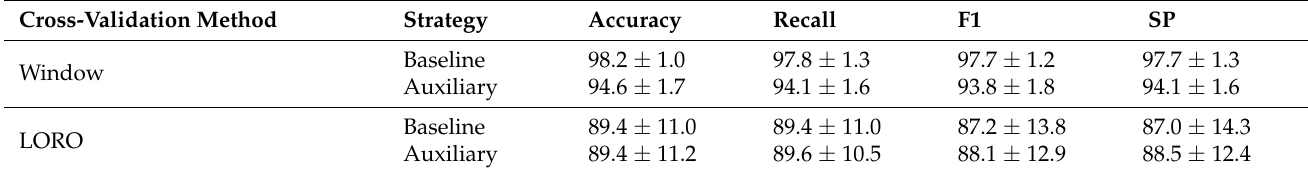
Table 9. Figures of merit measured from the window-based and LORO cross-validation methods for the MaxPro approach. Calculated using the auxiliary classifier of the